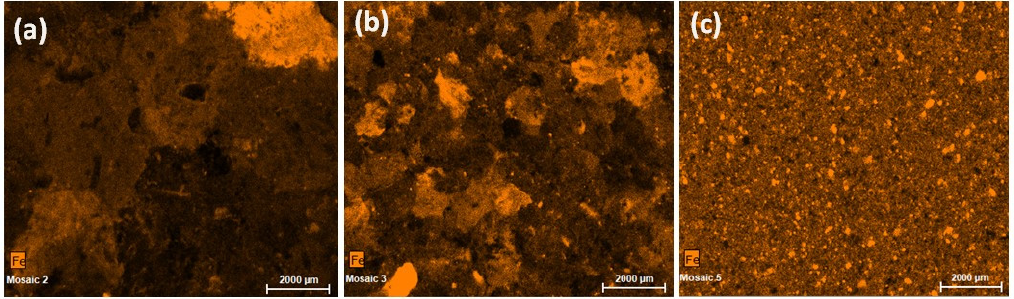
Figure 3. µ-XRF 2D mapping outputs for the element Iron (Fe). ( a ) Grain-size distribution: ≥ 2 mm to <3 mm; ( b ) <2 mm to ≥ 500 µm; ( c ) <250 µm.